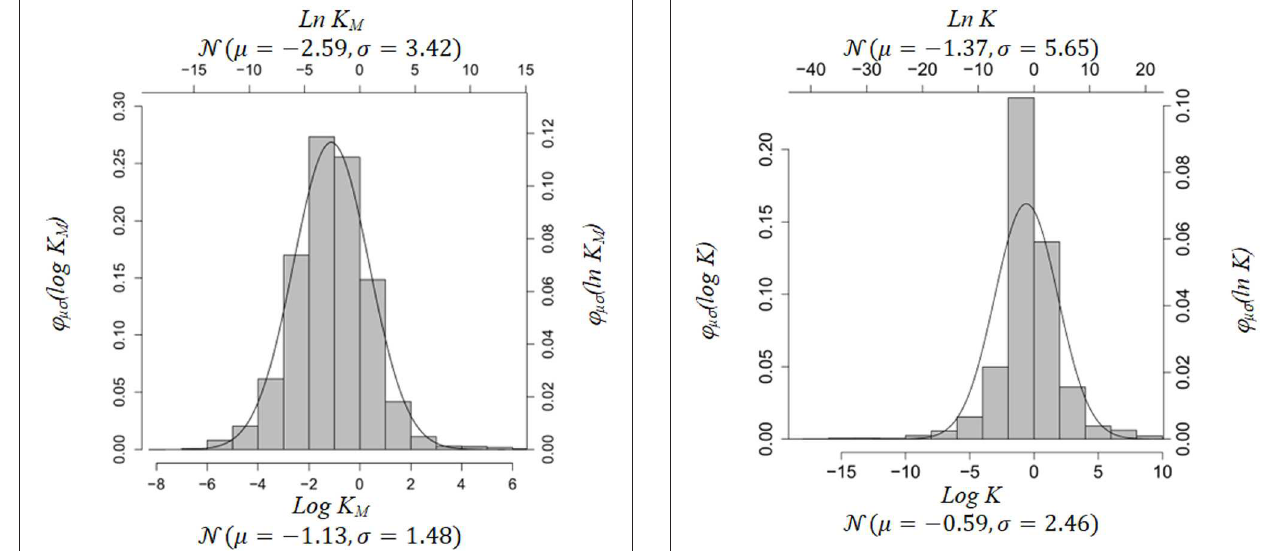
FIGURE 1 | Empirical distribution of K M , using Homo sapiens data from Brenda Database [ 30]. Source: https://www.brenda-enzymes.org.